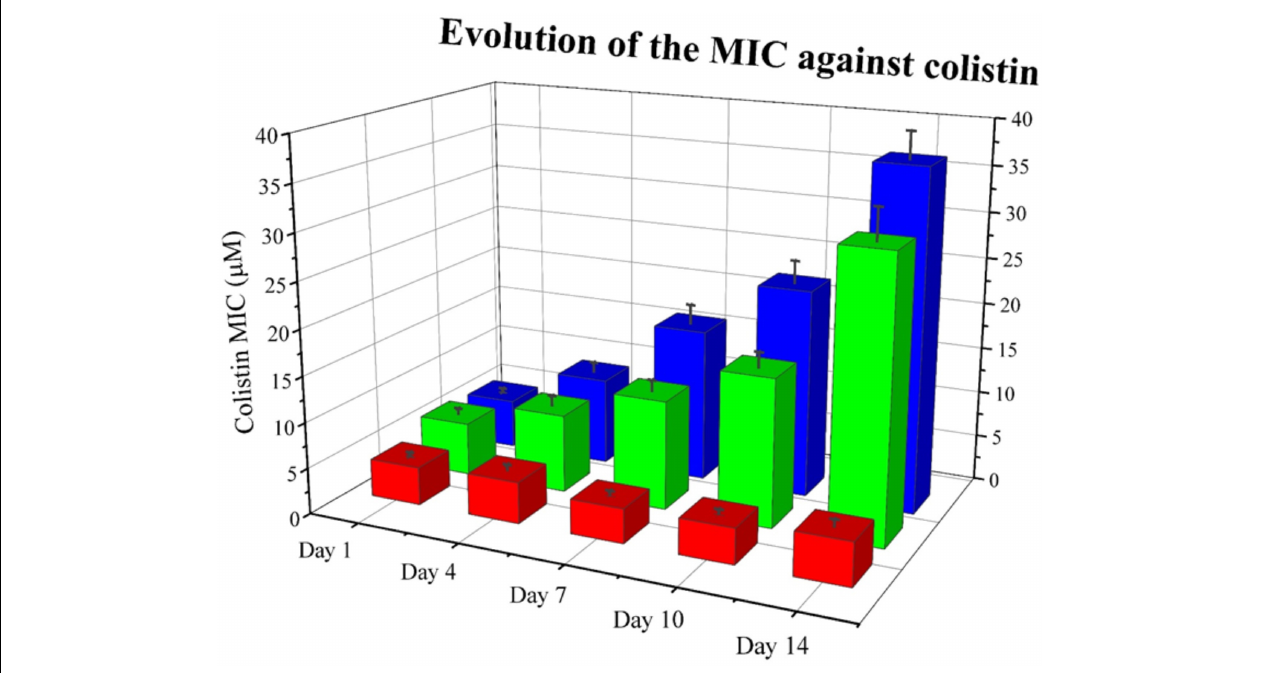
FIGURE 8 | Evolution of the mean MIC value for colistin of each assayed condition in Assay 2. Overall reduction of calculated MIC for colistin is observed for samples supplemented with RNase 3/1. Red corresponds to the negative control, blue to the colistin alone condition and green to the colistin + RNase 3/1 condition. Data from selected days is shown. The raw data used to produce the figure is shown in Supplementary Figure S6 . Error bars show the standard error of the